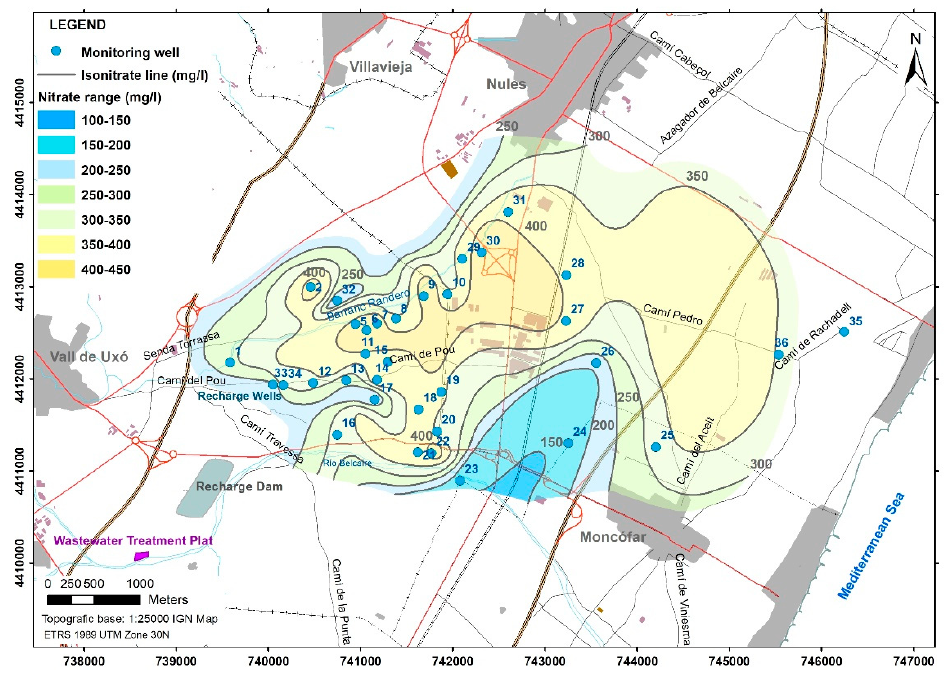
Figure 3. Maps of chlorides ( up ) and nitrates ( down ) concentrations in the Rambleta area, October 2012 (modified from [40]). Table 1. Identification of the sampling points.